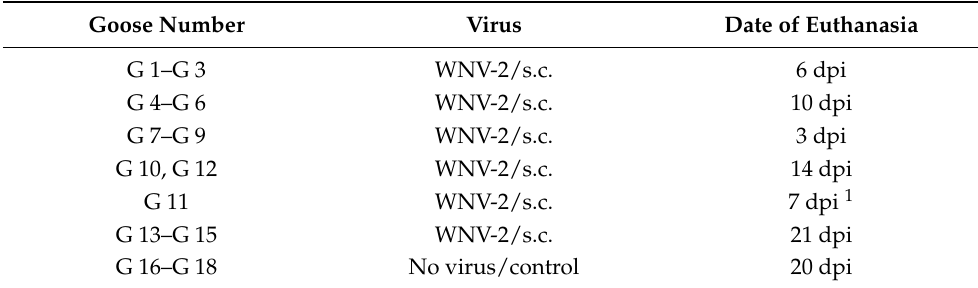
Table 1. Number of geese and necropsy time